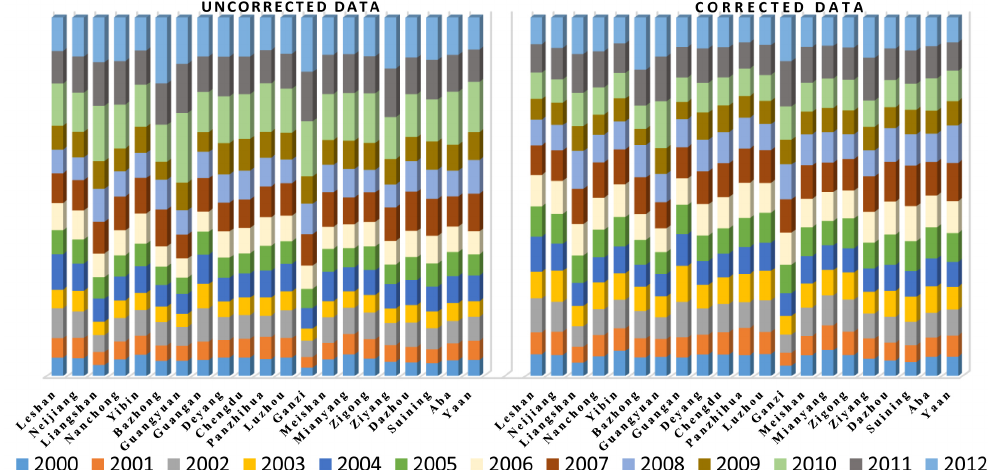
Figure 2. Normalized total lightness of uncorrected and corrected